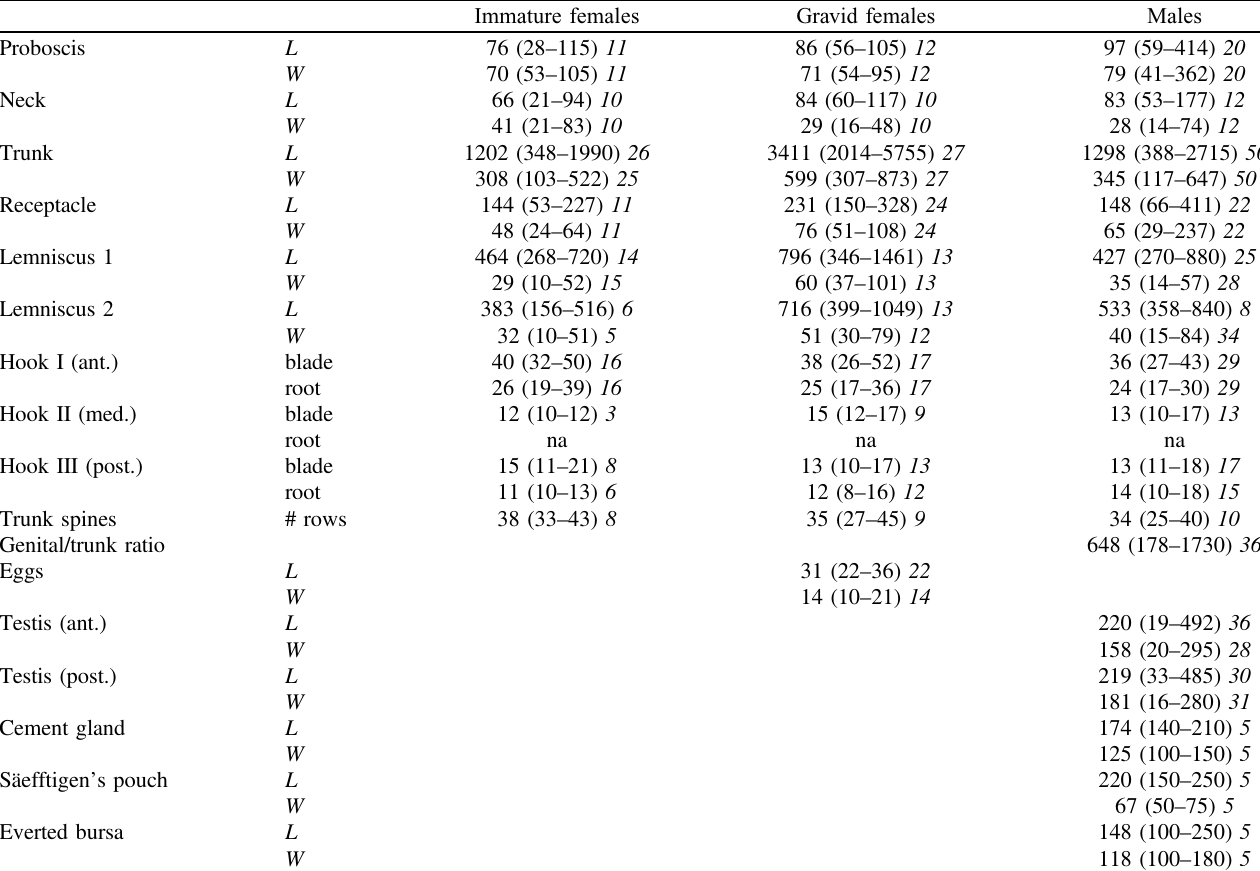
Table 4. Morpho-anatomical metrical data for female specimens (immature with or without ovarian balls, and gravid) and male specimens (all stages of development combined) of Acanthogyrus ( Acanthosentis ) cf. tilapiae from Coptodon guineensis at Sebkha Imlili. Data are averages in l m, followed by ranges in parentheses and number of specimens studied in italics. L = length; W = width; na = data not